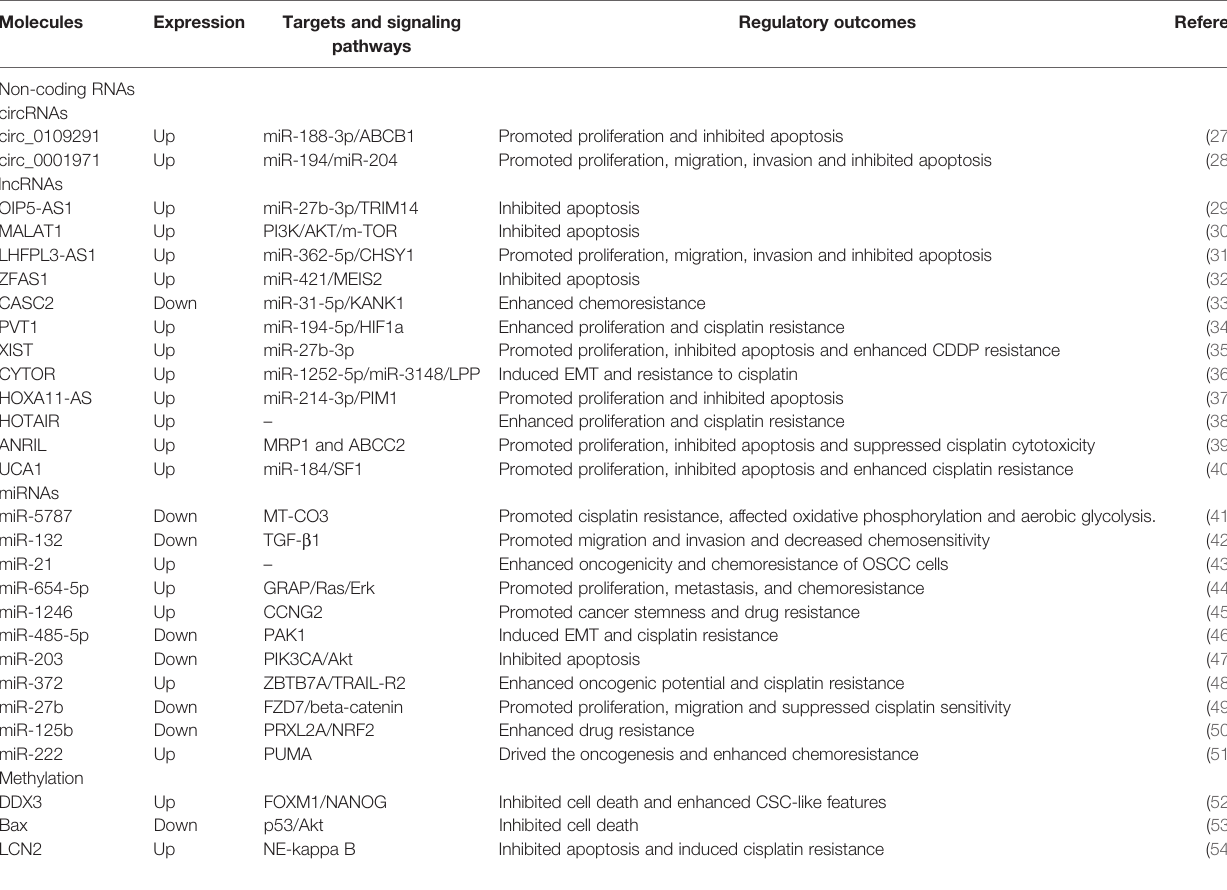
TABLE 1 | Epigenetic mechanisms and cisplatin resistance in OSCC.